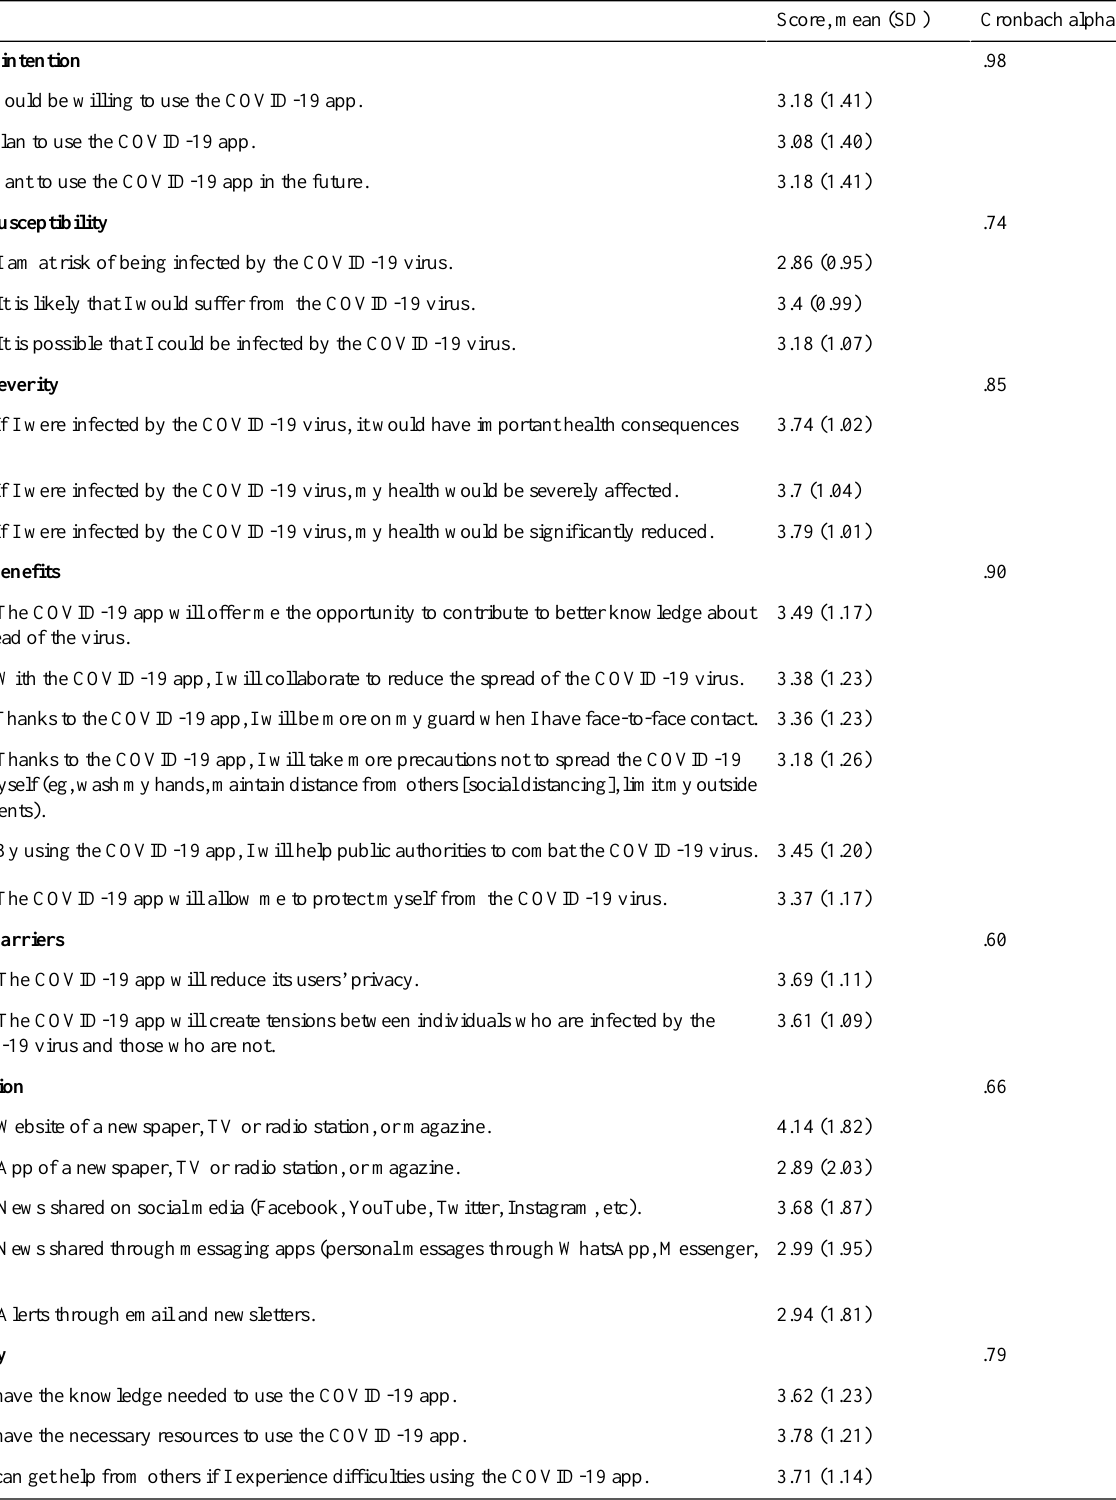
Table 1. Description of study